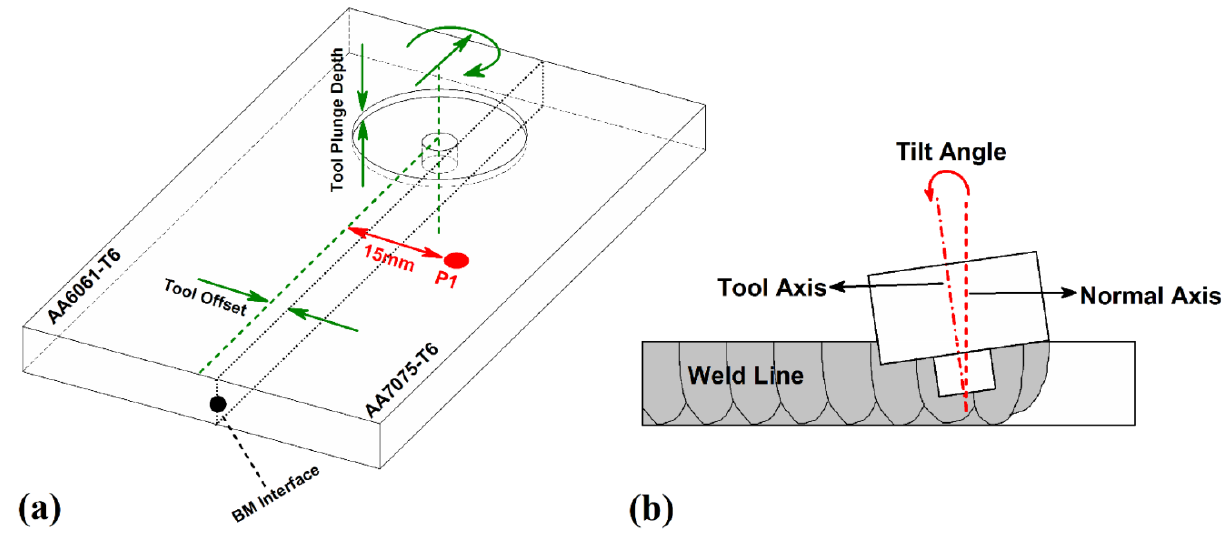
Figure 1. ( a ) Schematic view of tool offset and plunge depth, and ( b ) tool tilt angle. To perform the FSW joint, two dissimilar aluminum alloys of AA6061-T6 and AA7075- T6 were used and cut in dimensions of 120 × 50 × 5 mm. The raw materials were obtained